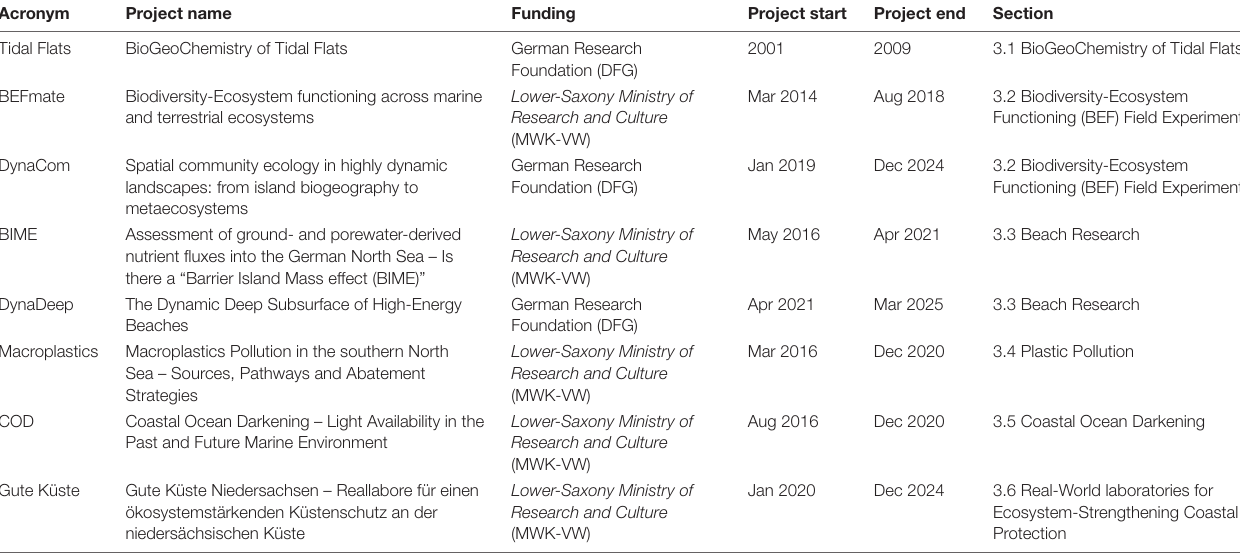
TABLE 4 | Overview of projects highlighted